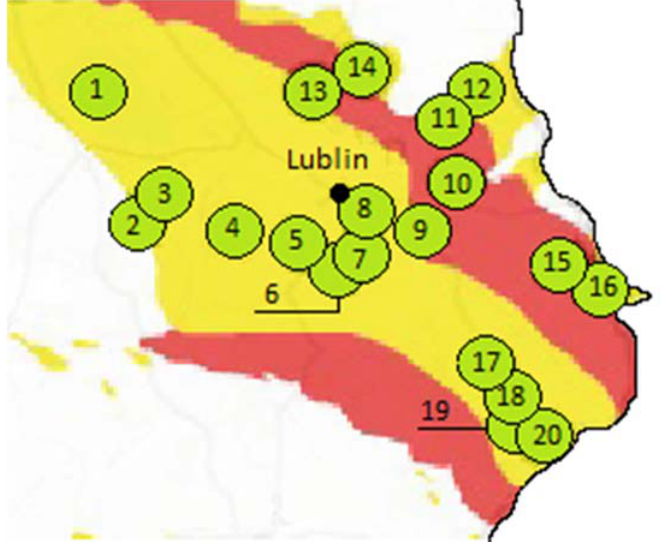
Figure 5. Locations of the abovementioned boreholes in the Lublin Basin: the yellow area signifies areas of lower or undefined gas-bearing potential in shale, the red area signifies areas of initially documented gas-bearing potential in shale of the Lower Paleozoic. 1—Magnuszew IG1; 2—B